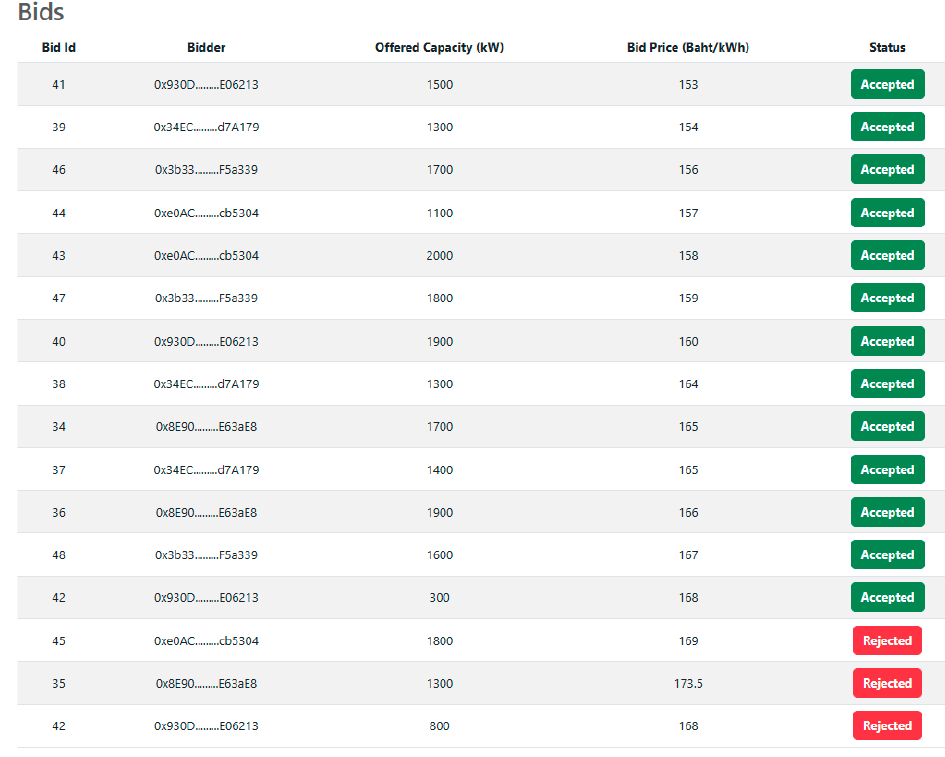
Figure 7. Bidding results.